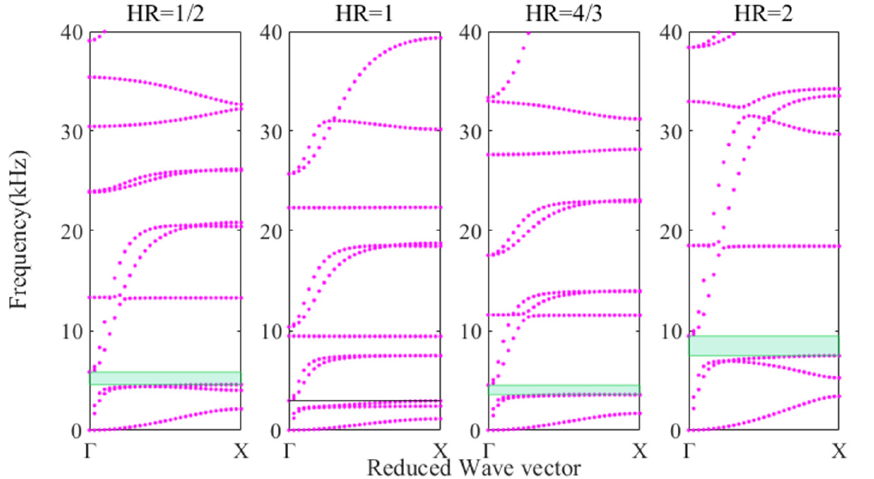
Figure 8. The influence of pillar height ratio HR on the dispersion curve of the HPFC.